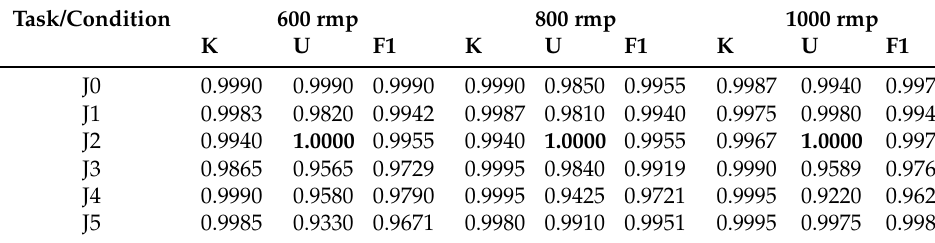
Table 7. Experimental results of the JNU dataset.